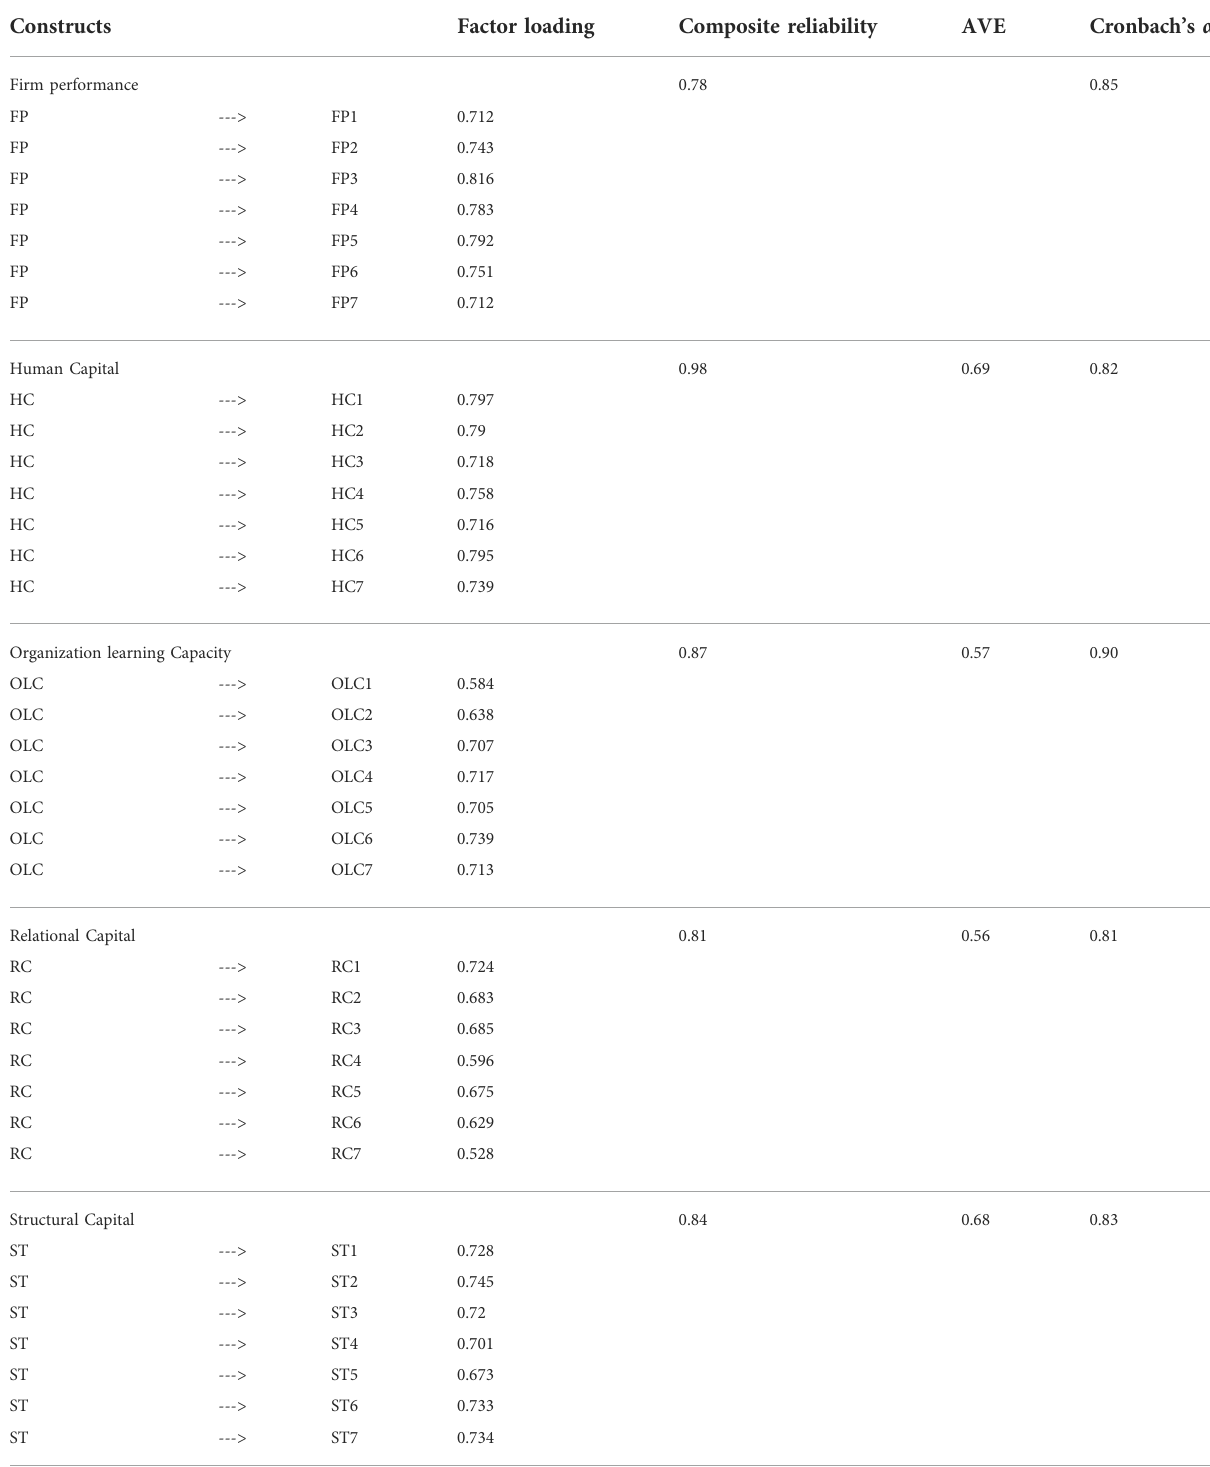
TABLE 3 Reliability and validity